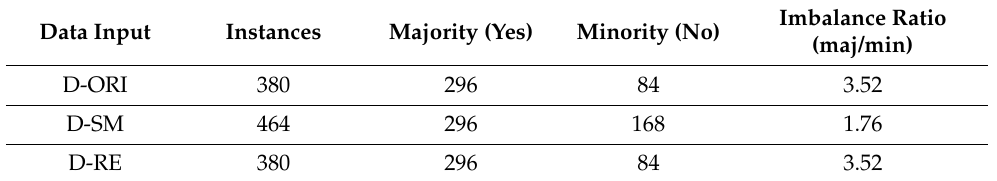
Table 2. Research data set after data